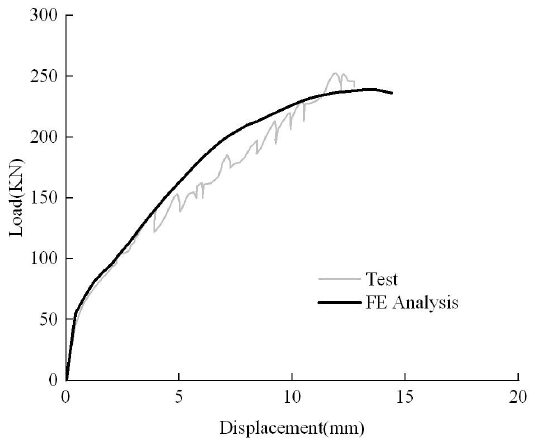
Figure 6. Test and FE load–displacement curves of specimen SB1. Table 3. Test and FE Results.